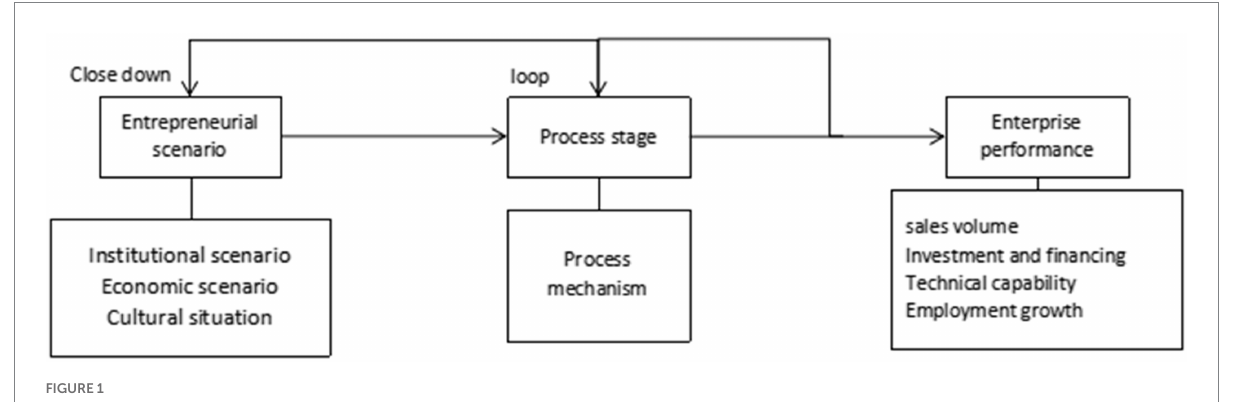
FIGURE 1 Research